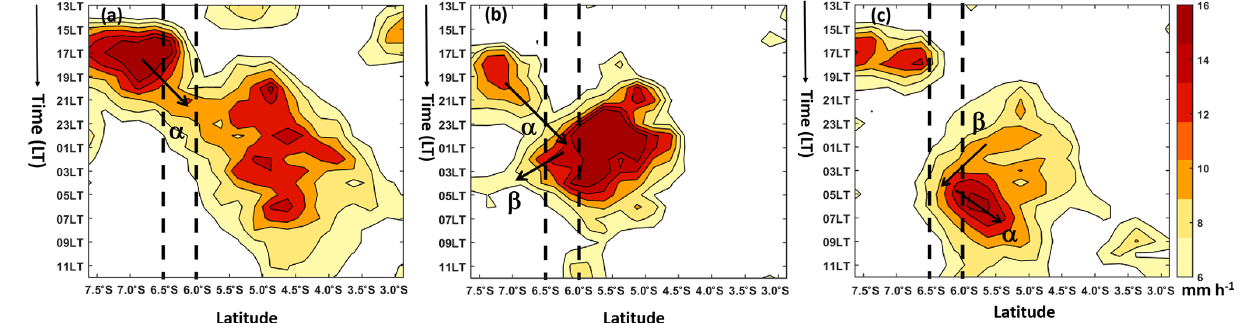
Figure 6. Hovmöller diagrams, same as Fig. 5, except for the 99th percentile (P99) values of the gridded hourly